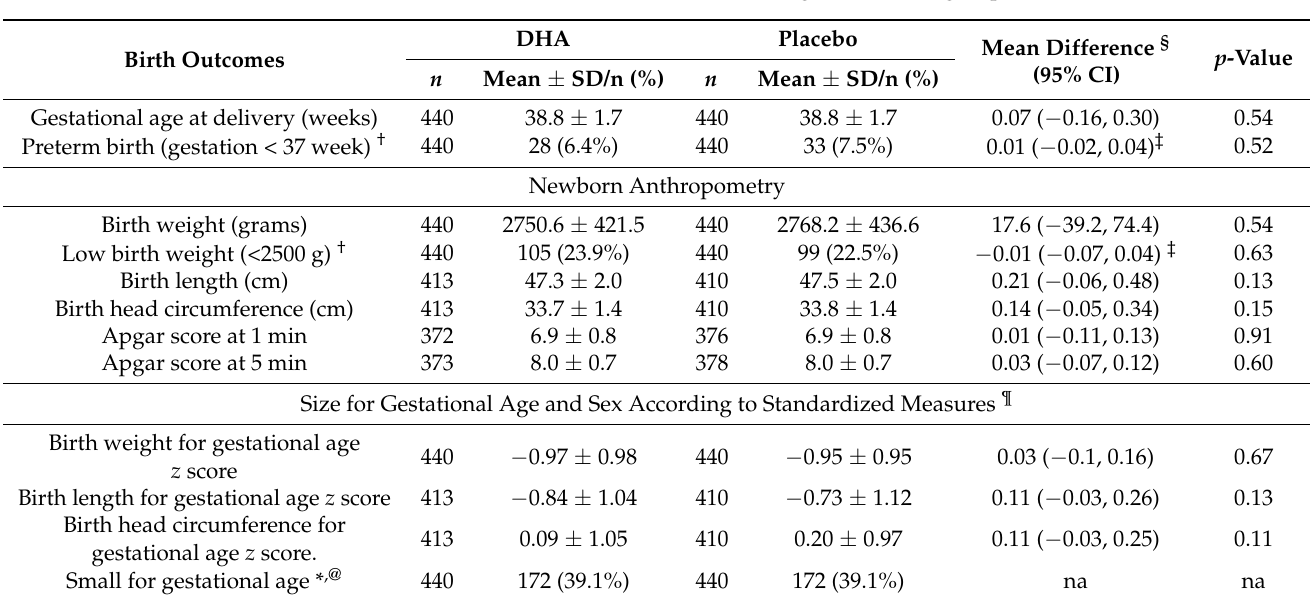
Table 3. Birth outcomes for all live births according to treatment